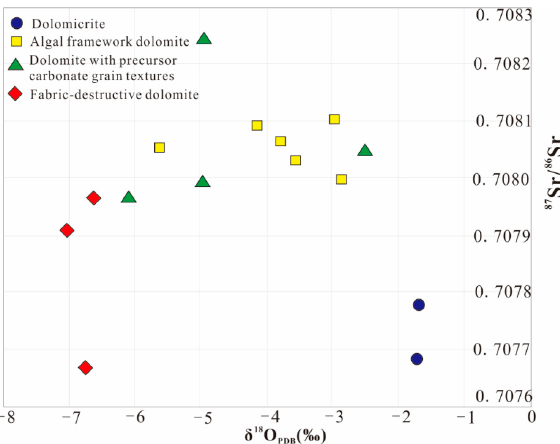
Figure 5. Plot of 87 Sr/ 86 Sr ratios and δ 18 O values of the dolomicrite, fabric-retentive dolomite, and fabric-destructive dolomite of the Leikoupo Formation, Western Sichuan Basin.